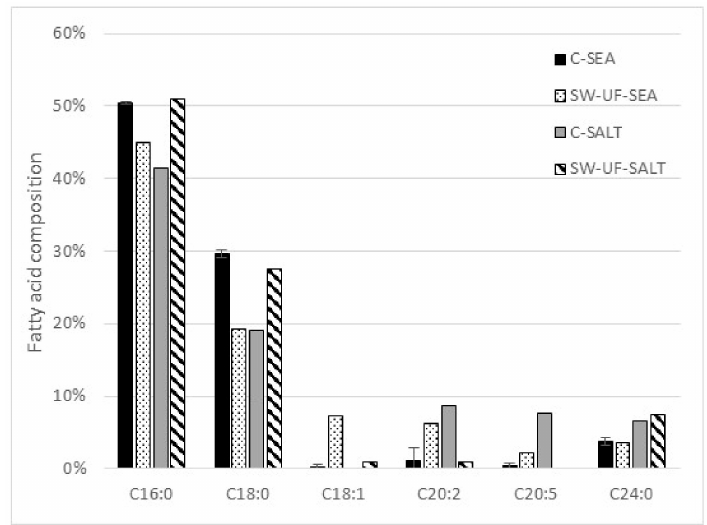
Figure 2. Fatty acid methyl esters (FAME) composition of P. cruentum grown in control and swine wastewater media. N = 2 for C-SEA and SW-UF-SEA, N = 1 for C-SALT and